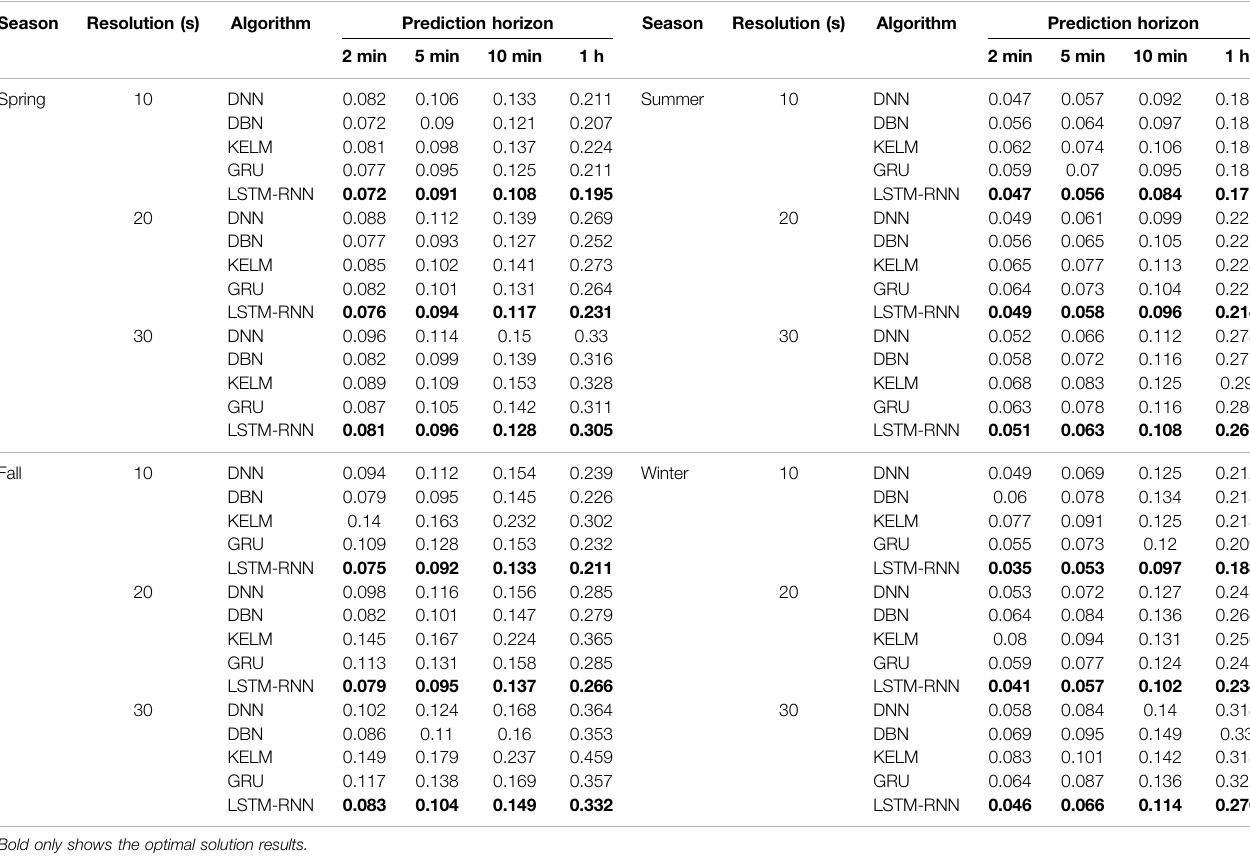
Bold only shows the optimal solution results.